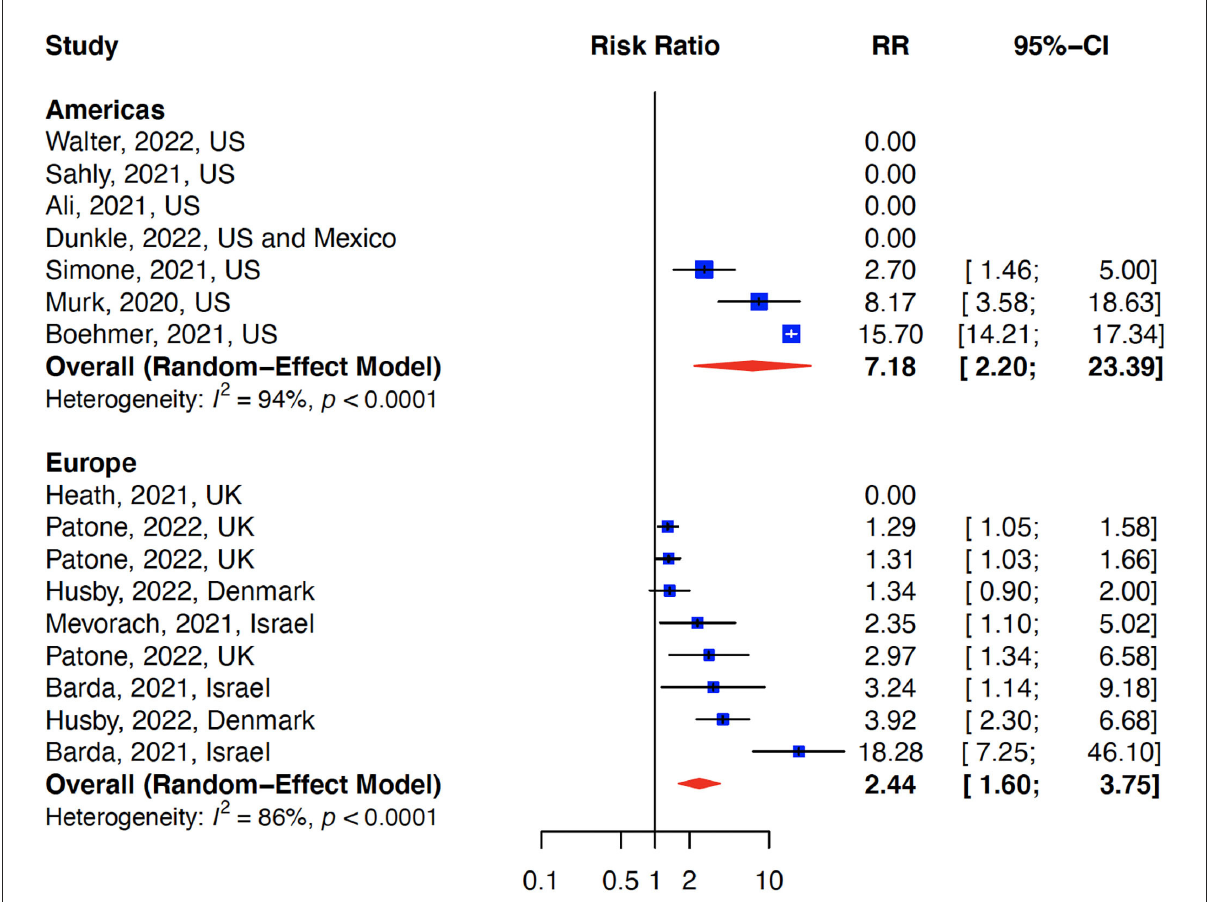
FIGURE4 Myocarditis after COVID-19 vaccination/Infection stratified by WHO regions. The risk of myocarditis was higher in the Americas (US and Mexico) compared to Europe.